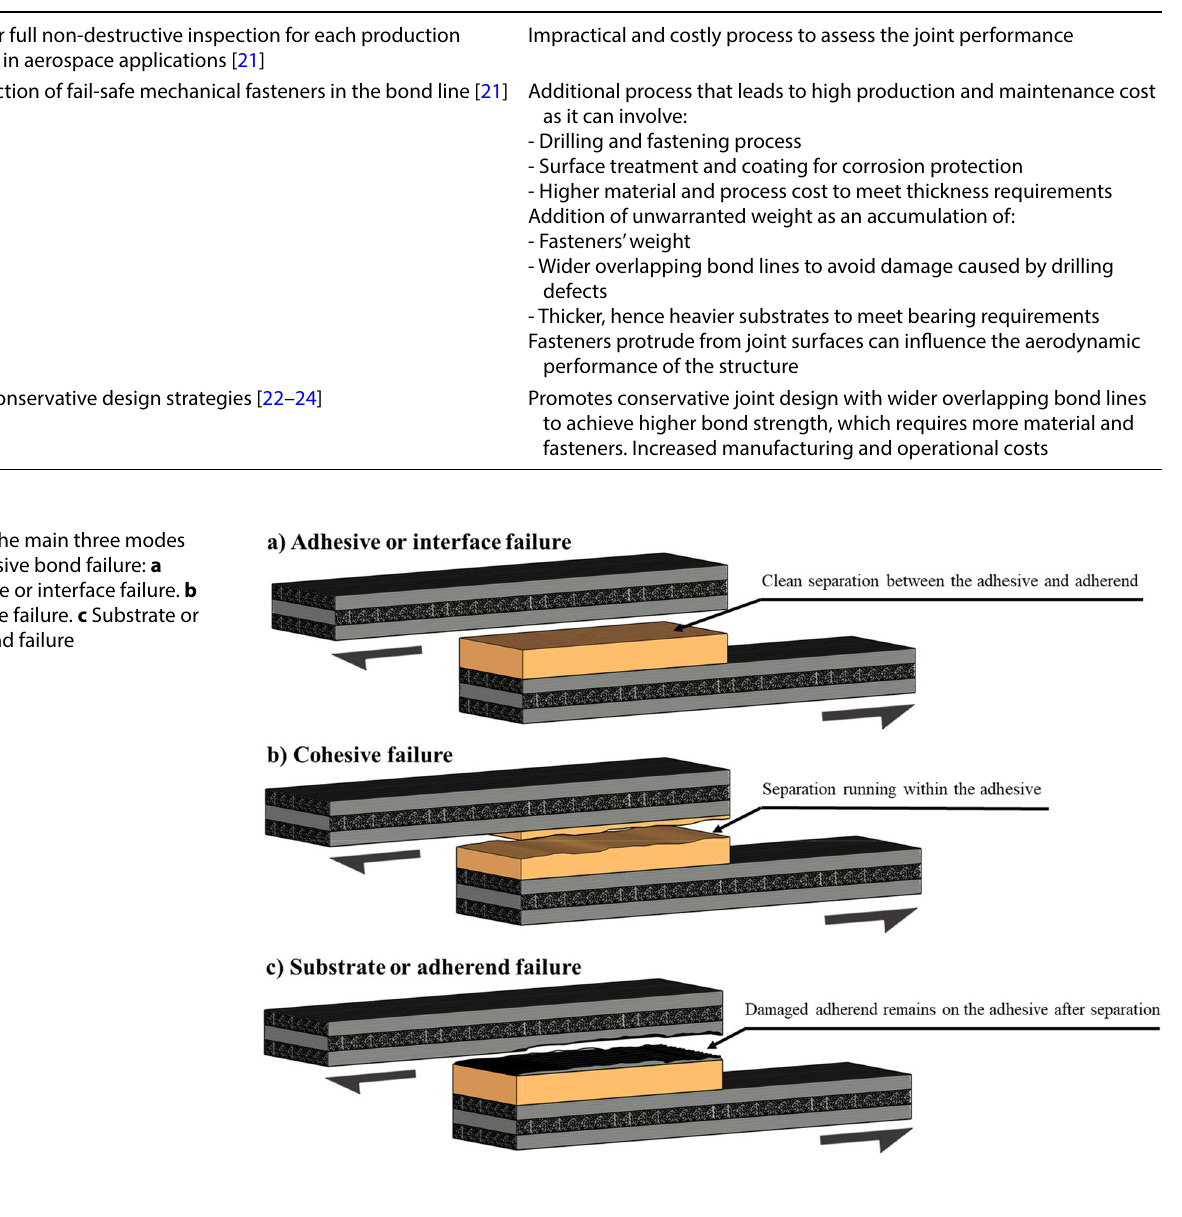
Table 2 Adhesive bonds conservative limitations in the context of advanced structural applications Limitations Impact